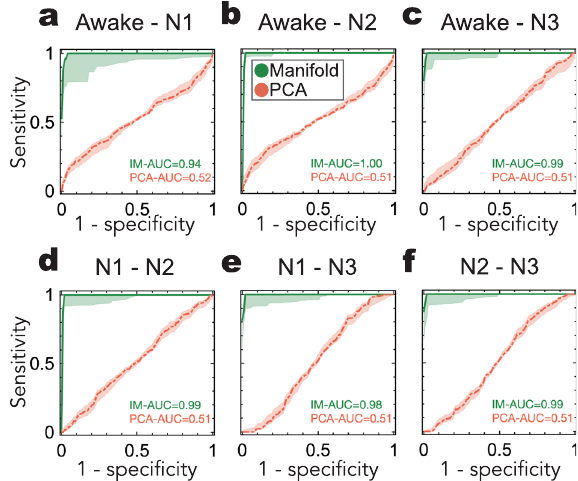
Fig. 4 Receiver operating characteristic (ROC) for all pairwise comparisons between brain states on the intrinsic manifold of brain dynamics and compared to PCA. ROC reveals the relationship between sensitivity and 1-speci fi city. The area under the curve (AUC) indicates how accurately the two compared states can be classi fi ed using only one dimension of the embedding space. ROC curves of the classi fi cations performed on the intrinsic manifold (shown in green) and on PCA (shown in red) are illustrated for all pairwise stage comparisons: a between wakefulness and N1, b between wakefulness and N2, c between wakefulness and N3, d between N1 and N2, e between N1 and N3, f between N2 and N3. For all stage pairwise comparisons between wakefulness, N1, N2, and N3, intrinsic manifold yield signi fi cantly higher AUC (for all comparisons, p -value < 0.001, Wilcoxon Rank-sum two-sided test, corrected for multiple comparisons via FDR) in the fi rst three-manifold dimensions. Shaded areas indicate the distribution of AUC values across different participants, for performed on their intrinsic manifold, whereas red dots correspond to the AUC values in the PCA space. The solid lines indicate the mean of the distribution across classi fi cations and shaded areas indicate their standard error of the mean (N =